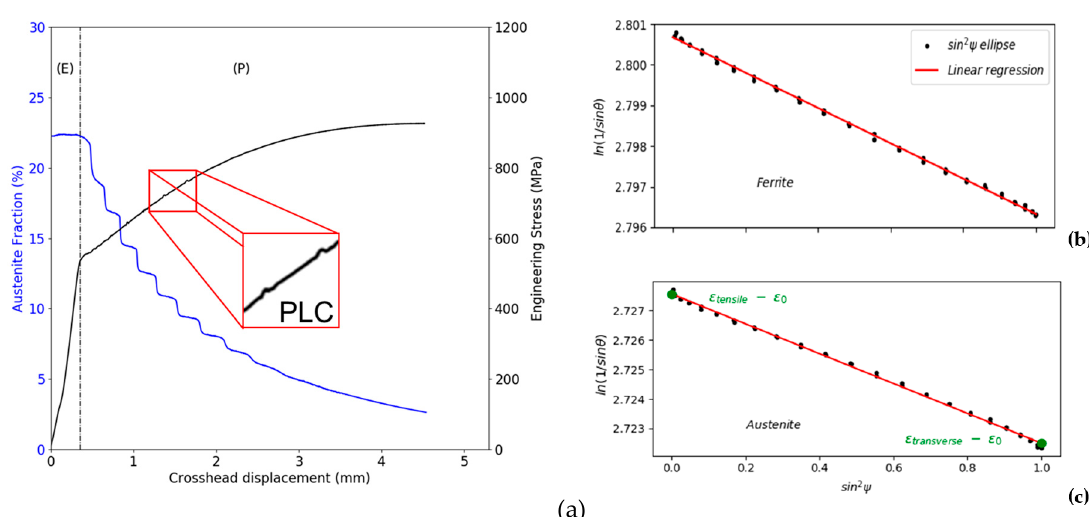
Figure 3. ( a ) Evolution of the austenite fraction determined by the Rietveld refinement (blue) and engineering tensile curve (black). The error on phase fraction is 1% with Rietveld refinement. (E) and (P) correspond to the elastic and plastic regimes, respectively. Measured strains ( b ) for the {211} α and ( c ) for the {311} γ planes as a function of sin² ψ in the elastic regime. Each dot (black) corresponds to a measurement in a 4° sector of the Debye-Scherrer. The Y-axis ln (1/sin θ ) is linked to the strain in the φ , ψ direction by Equation: ln (1/sin θ ) = ε φψ – ln(sin θ 0 ). A linear interpolation (red curve) is represented for the sake of readability. The green dots correspond to the elastic strain measured in the tensile and transverse directions, respectively.